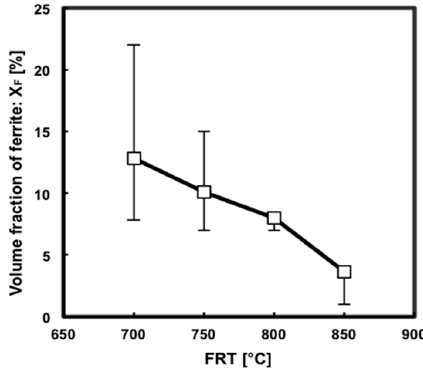
Figure 3. Variation in the volume fraction of ferrite with the finish rolling temperature.